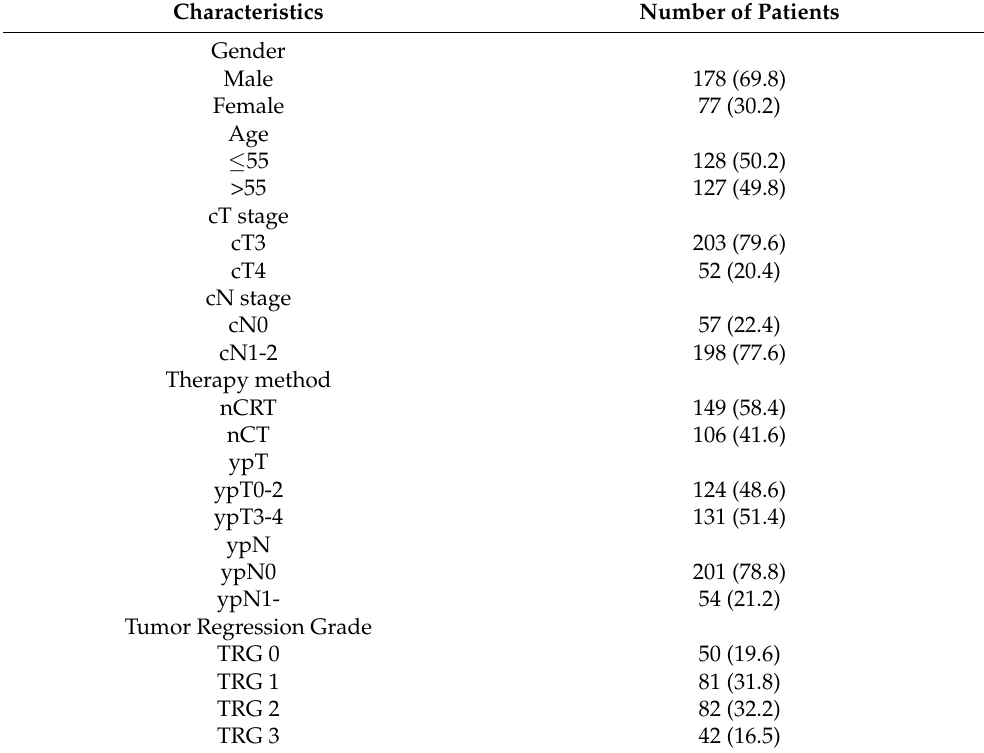
Table 1. Patient